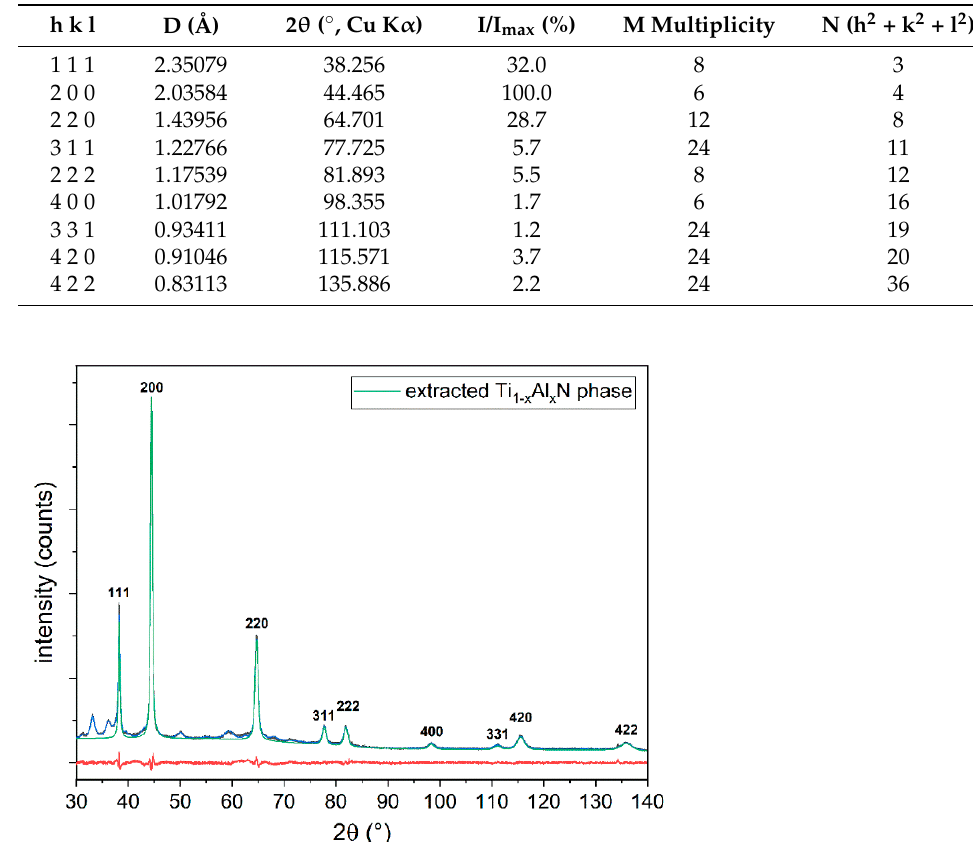
Table 2. Powder diffraction data of the fcc-Ti 1 − x Al x N powder.